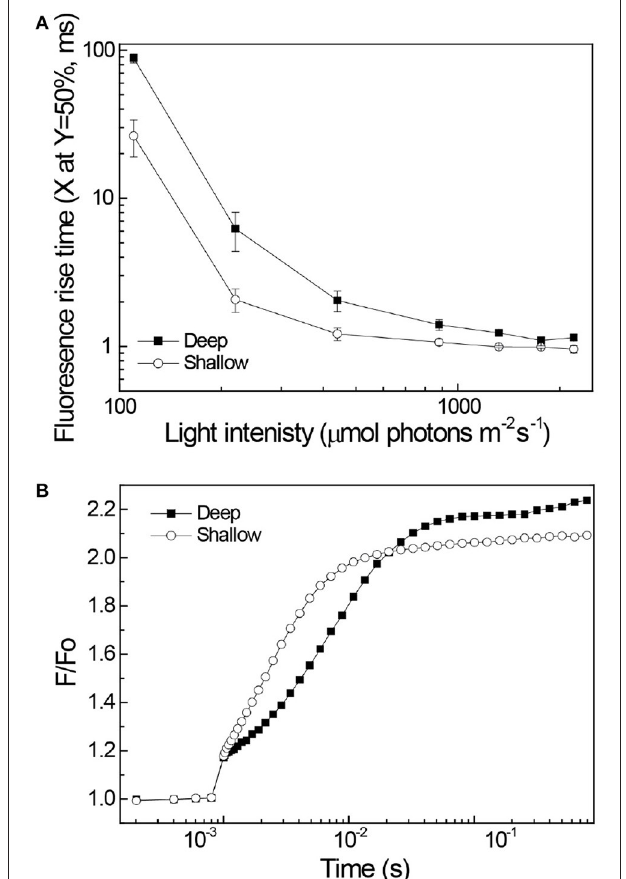
FIGURE 5 | Chlorophyll fluorescence rise kinetics. The actinic light was turned on at 10 − 3 s. (A) Shallow corals (3m) are represented by open symbols, mesophotic corals (65m) depth are represented by closed symbols. Curves fitted to a sigmoid trandline ( R 2 > 0.97 for all curves). The fluorescence rise half time, extracted from the sigmoidal fit, for deep and shallow corals is plotted as a function of the actinic light intensity. Standard deviation values calculated from three samples for each depth. Values represent the time for the signal to reach 50% of its maximum excitation. (B) An example for the raw data where 220 µ mole photons m − 2 s − 1 red light excitation (620nm) was